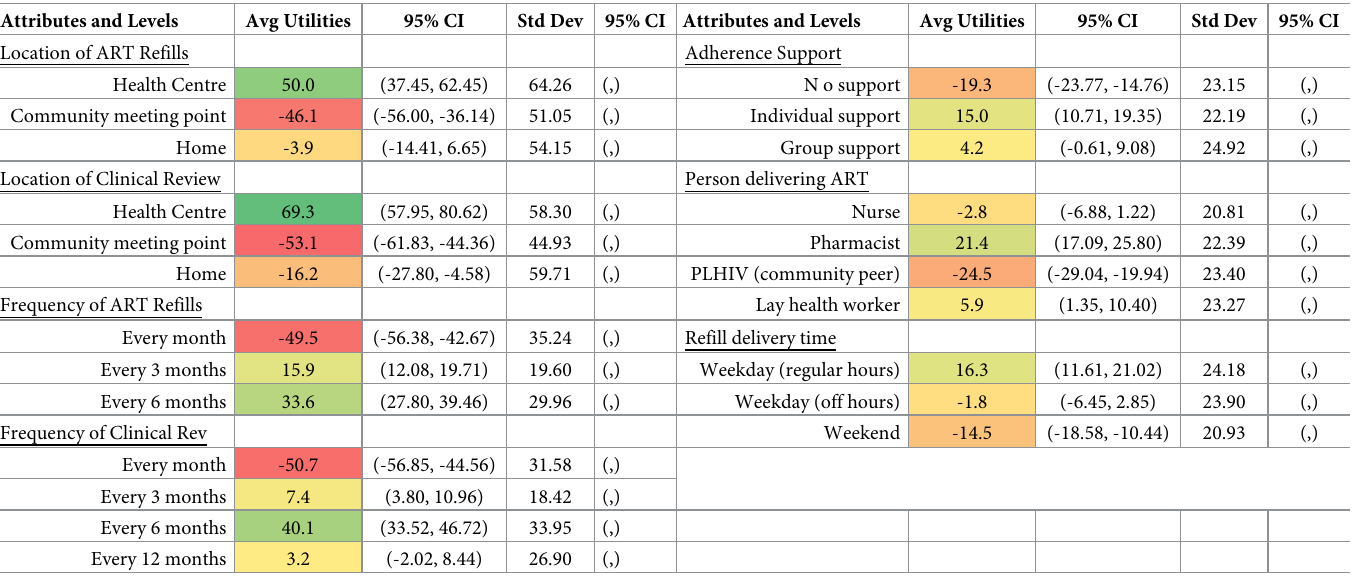
Table 5. Average utilities of all levels included in our